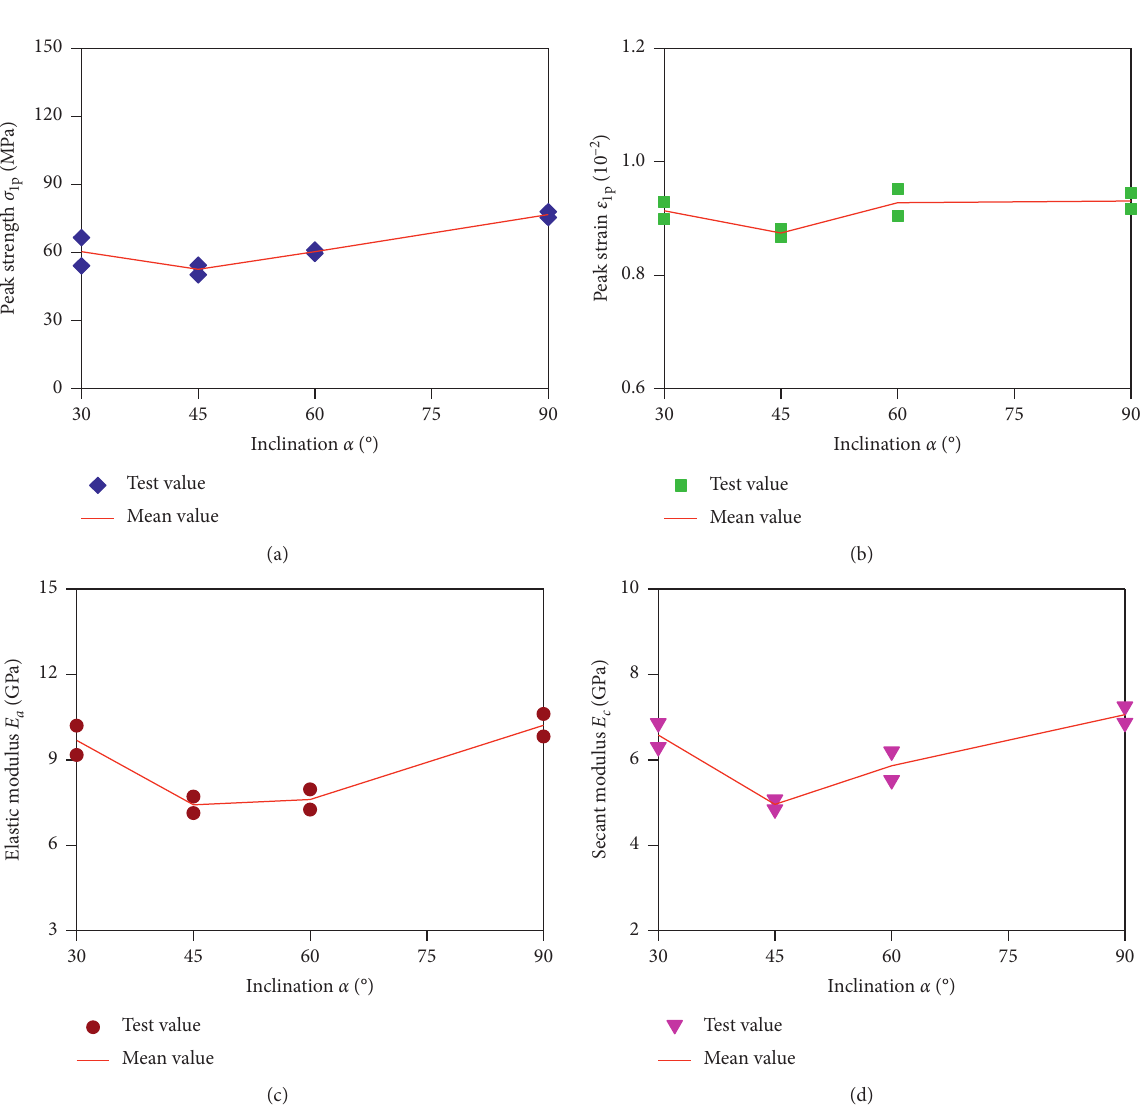
Figure 7: Effects of joint inclination on (a) peak strength, (b) peak strain, (c) elastic modulus, and (d) secant modulus of specimens, respectively ( l �